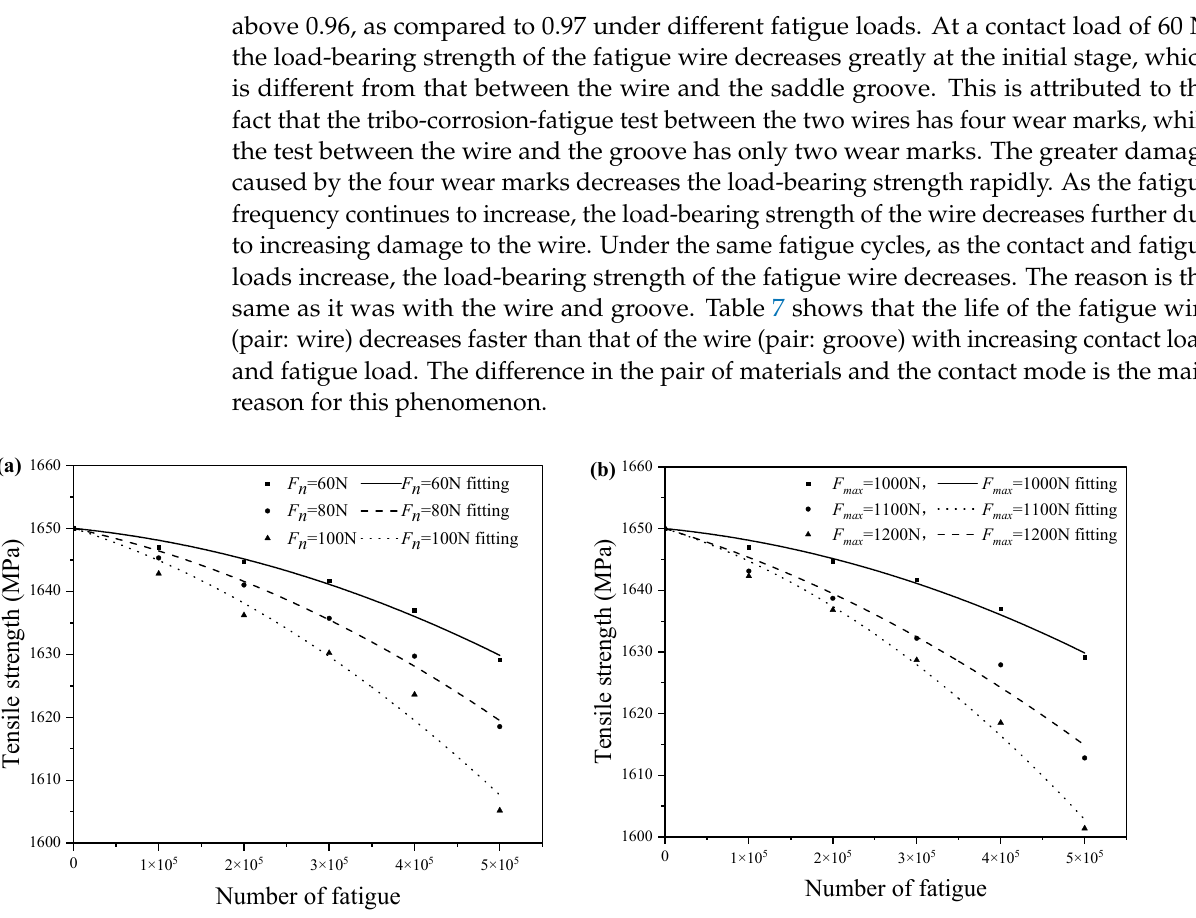
Figure 11. Strength degradation curves of the worn wire (pair: wire) under different contact loads ( a ) and different fatigue loads ( b ). Table 7. Fitting equation of worn wire (pair: wire) strength degradation. Fitting